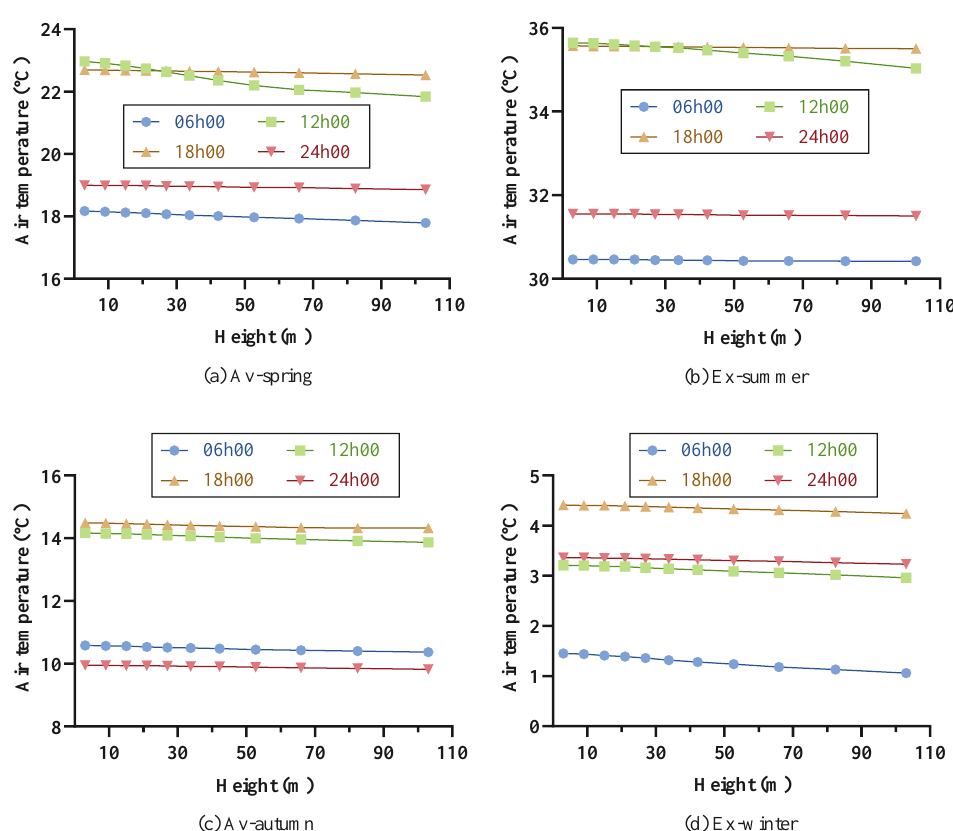
Figure 13. Air temperature evolution along height for four representative days of receptor N.